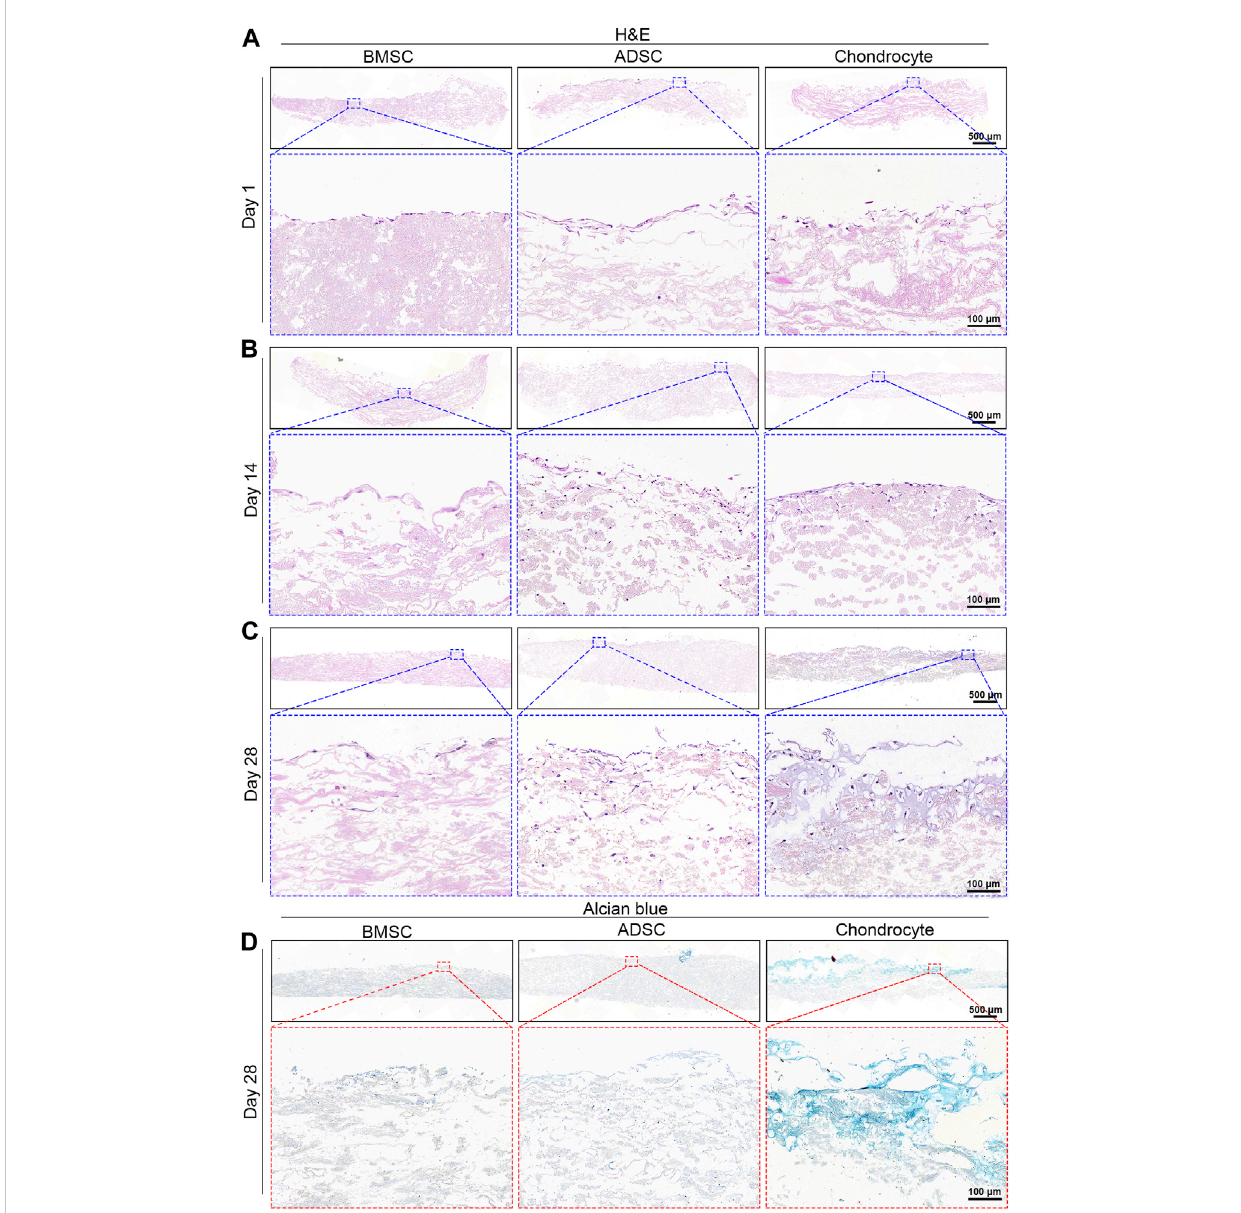
FIGURE 5 Histological analysis of cell-seeded scaffolds. H&E staining shows increased cell in fi ltration into scaffold over time (A – C) . Chondrocytes show intense positive Alcian blue staining while BMSC and ADSC are absent of Alcian blue staining (D)